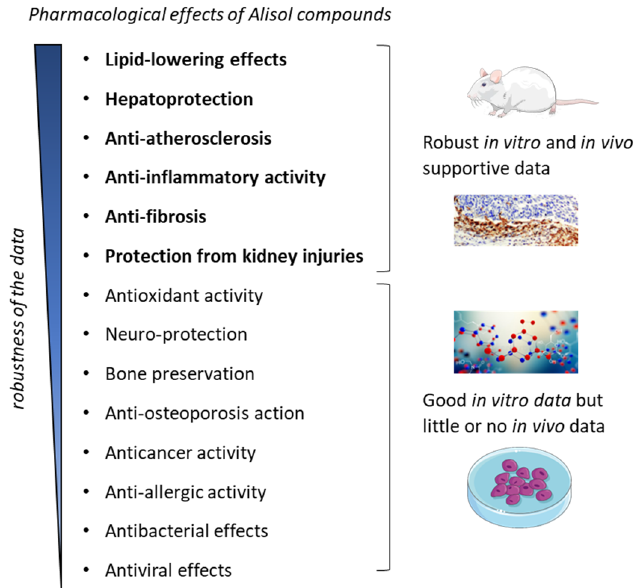
Figure 8. Pharmacological effects reported with alisol derivatives. The effects can be separated into two categories: the effects benefiting from robust in vitro and in vivo data obtained with animal models representative of the pathology (indicated in bold) and the effects evidenced essentially using in vitro data, with purified molecular systems and/or laboratory cell lines.